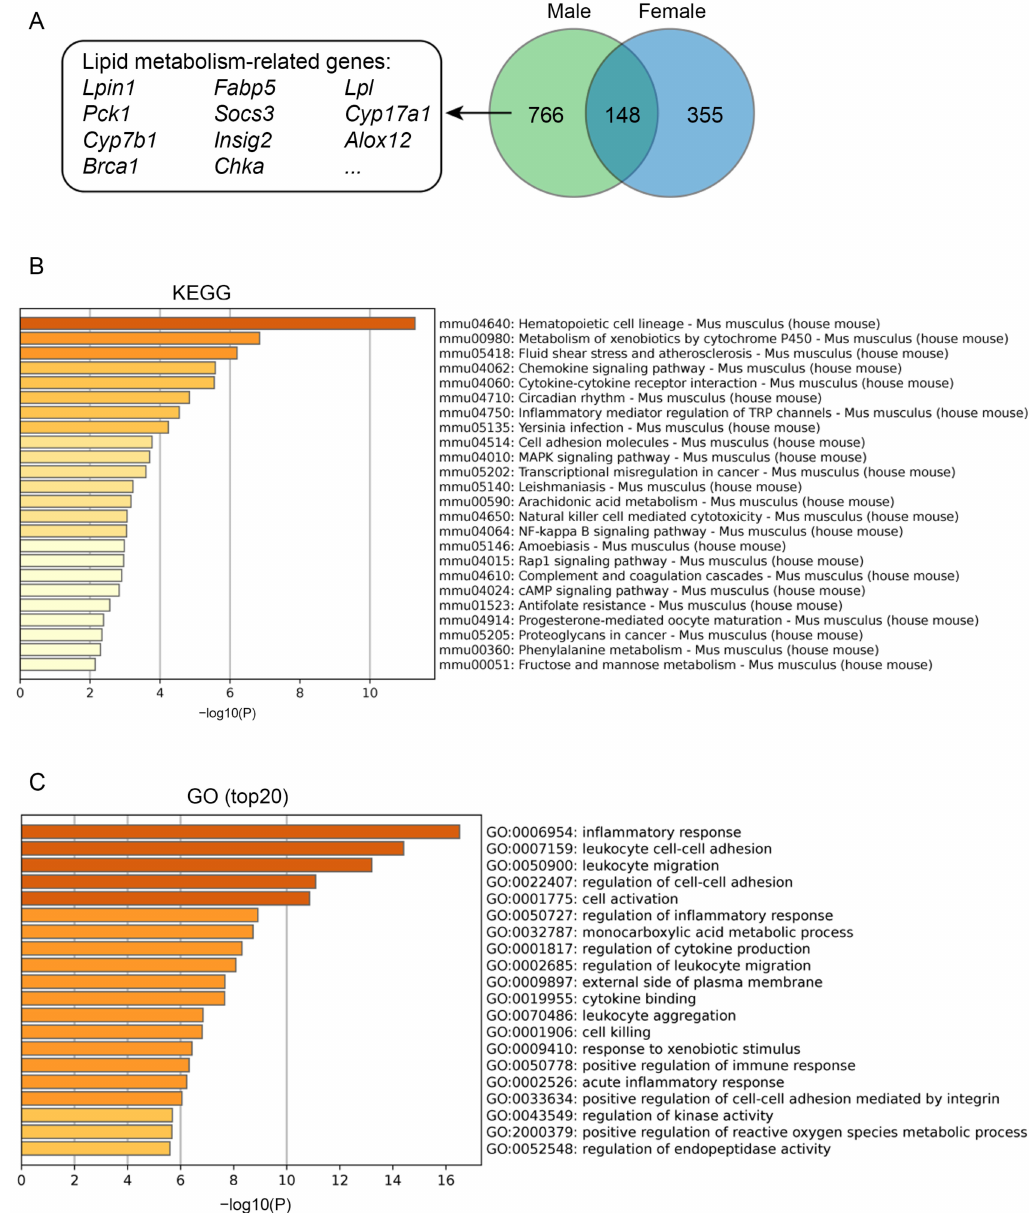
Figure 8. Comparative analysis of the liver transcriptomes of male and female B6-Chr1BLD mice. ( A ) A Venn diagram showing the overlap between DEGs of male and female B6-Chr1BLD mice vs. B6 mice. Partial lipid metabolism-related genes, which are only from male DEGs, are shown. ( B ) Enriched KEGG terms by genes that are only from male DEGs. ( C ) Top 20 enriched GO terms by genes which are only from male